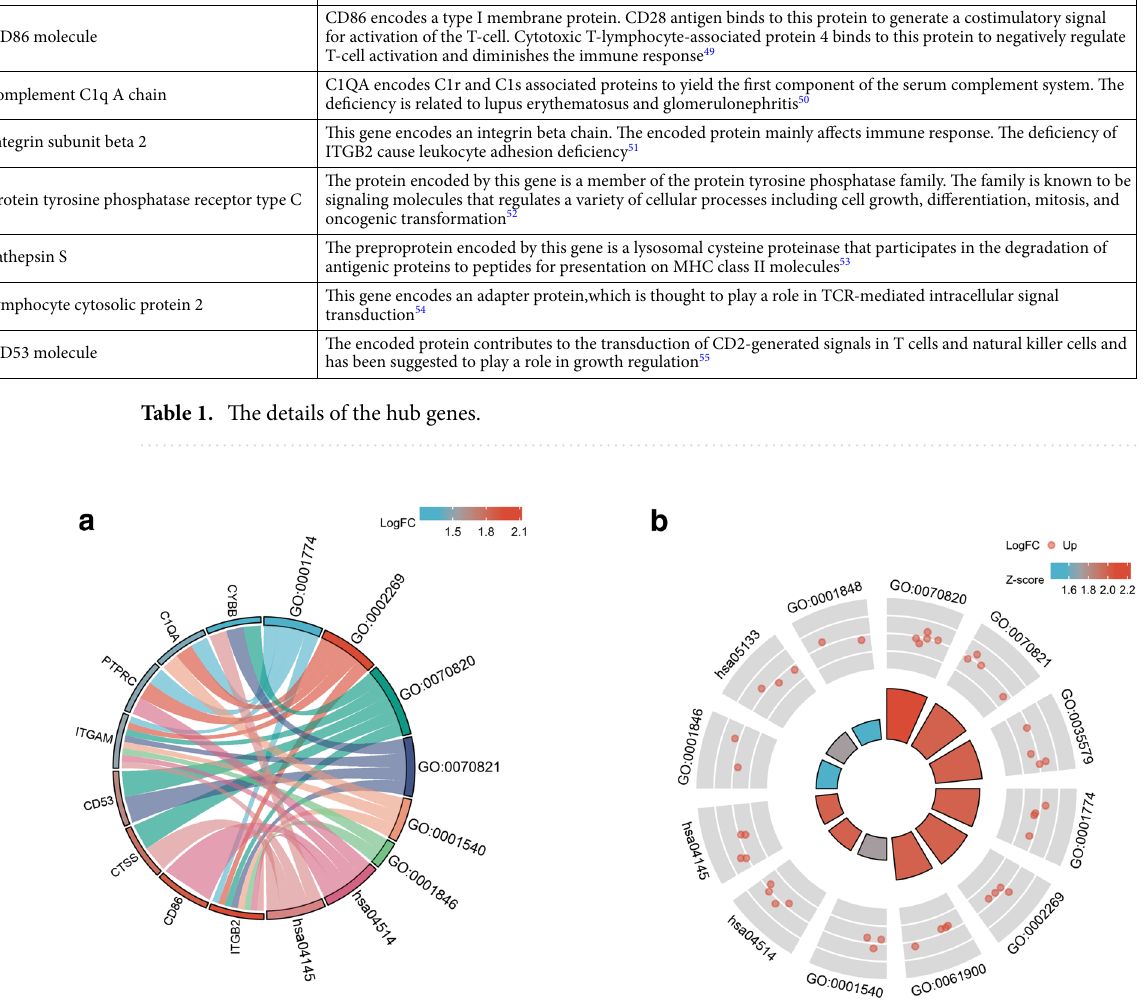
Figure 4. GO and KEGG enrichment analysis of the hub